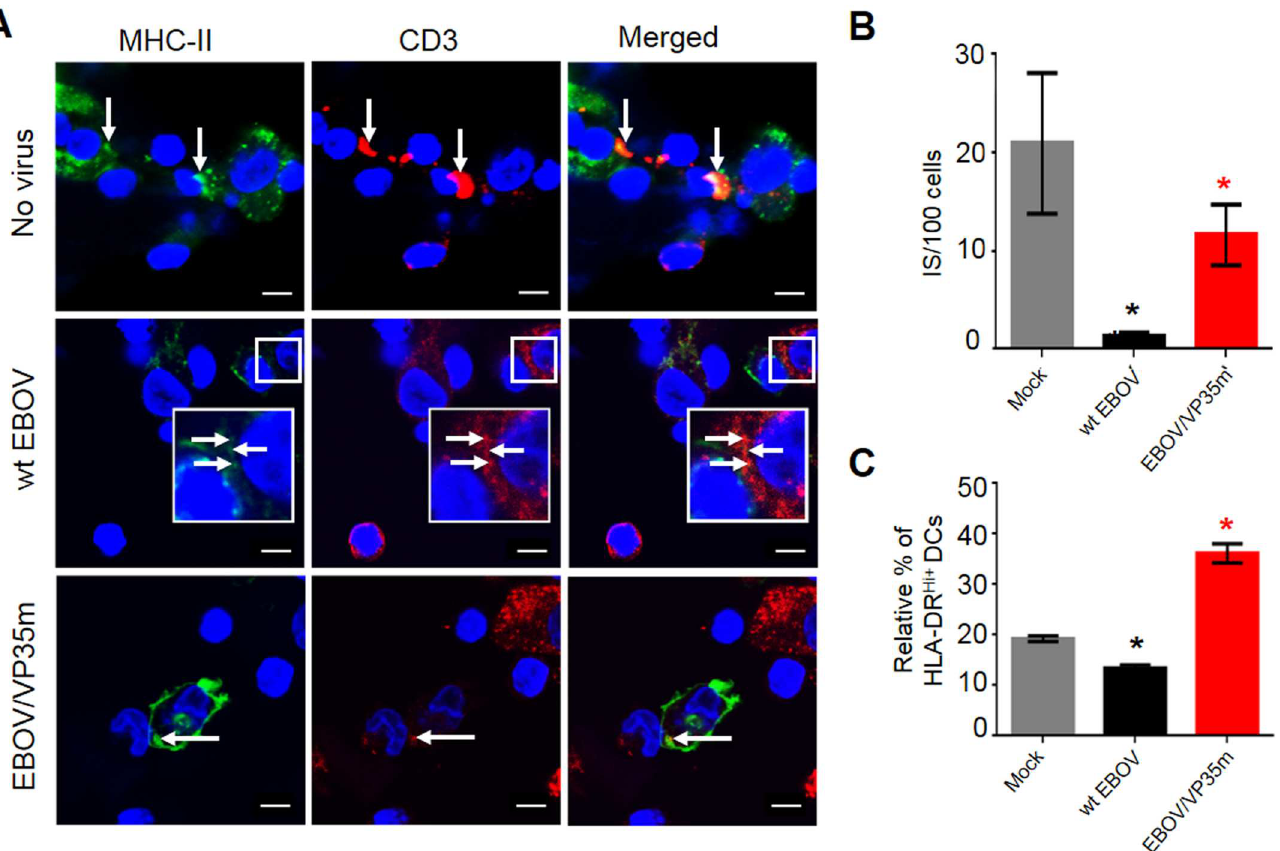
Fig 6. VP35 IID impairs the formation of immunological synapses. CMV-pulsed DCs infected with wt EBOV or EBOV/VP35m incubatedwith autologous CD4 + T cells. A . Confocalmicroscopydata showingco-localization of DC-expressed HLA-DR(green)and CD4 + T cell-expressed CD3 (red). Scale bar = 1 μ m. Immunologicalsynapses are shown by white arrows. Representative images from one of three donors analyzed.Note, a representative image of CD4 + T-cells co-culturedwith wt EBOV infected DCs demonstrates one of a very limited numberof dimly fluorescentHLA-DR + cells co-localized with CD3 + T cells. Since HLA-DR stainingof DCs infected with wt EBOV is dim, an inlet with increasedbrightnessto visualizeHLA-DR is shown. B . Numbers of CD4 + T cell—DCimmunological synapsescounted in 13 mm diametercover slips. Results are expressedas numbers of immunological synapses per 100 cells. C . Percentagesof HLA-DR + DCs in infected or mock-infected DCs determined by flow cytometry. Mean values with SE based on triplicate samples from one of two independent experiments performed with different donors, which resulted in essentiallysame results. B, C, black asterisks indicate significantdifferences to mock, and red asterisks indicatesignificantdifferencesto wt EBOV infection(p <